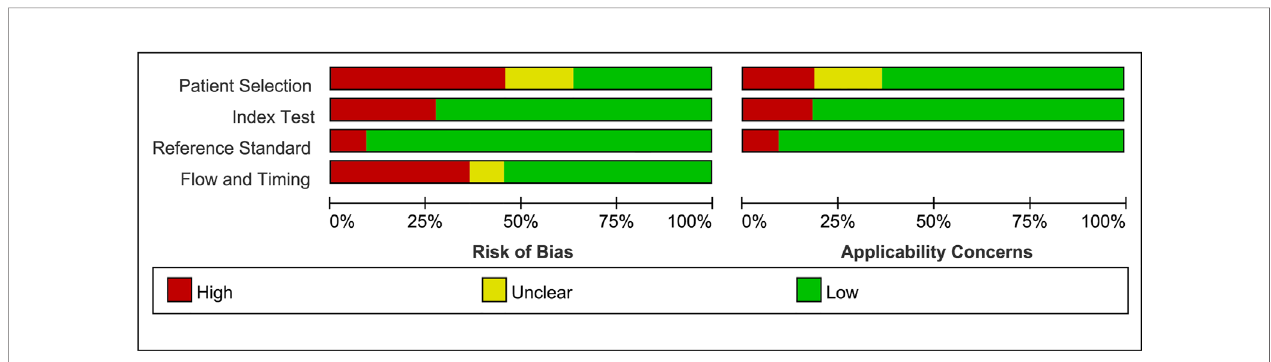
FIGURE 5 | Graphical display for QUADAS-2